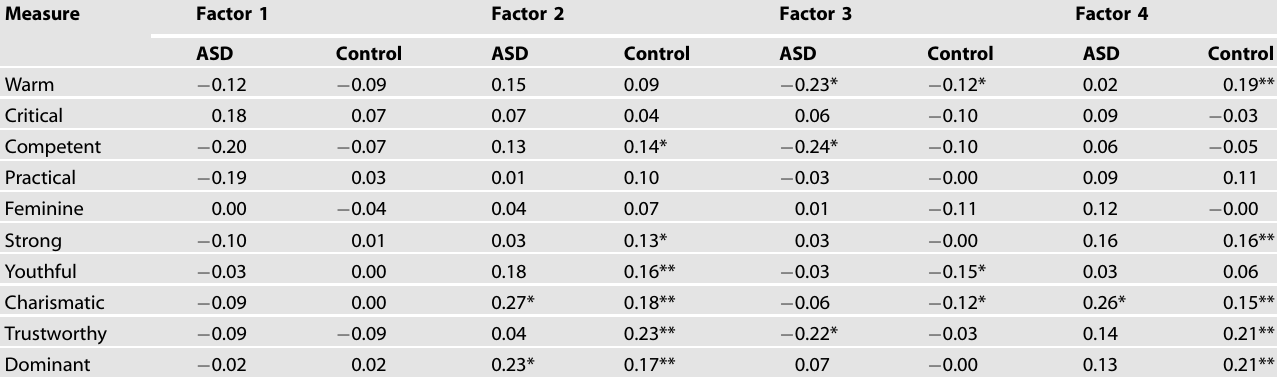
Table 2. Correlations between factor scores and social trait judgments.